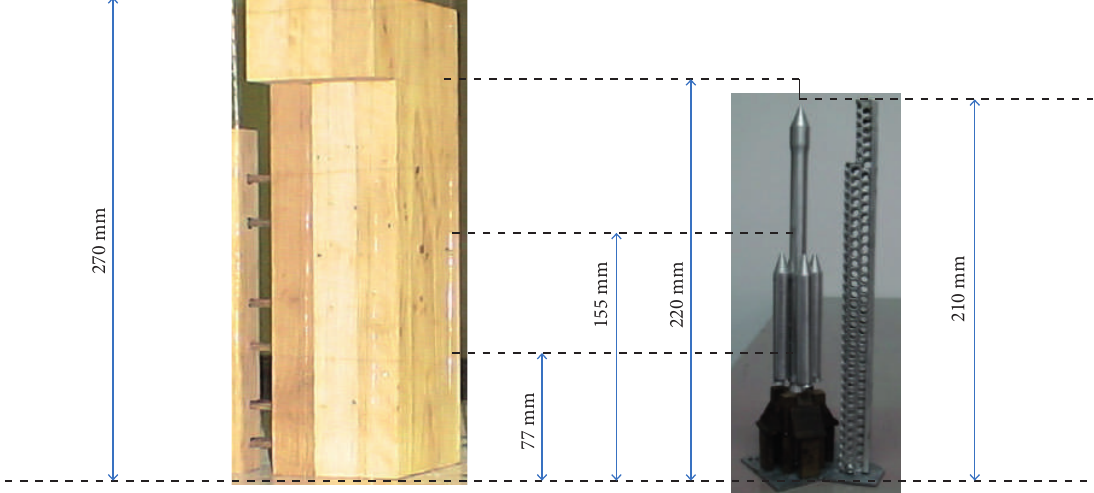
Figure 11. Heights of the horizontal plane of laser related to the heights of the MIT and launch